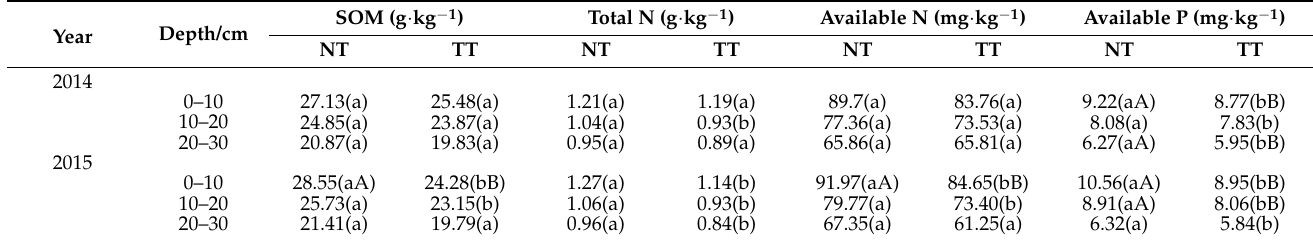
Table 2. SOM (g · kg − 1 ), total N (g · kg − 1 ), available N (mg · kg − 1 ), and available P (mg · kg − 1 ) for NT and TT trial in 0–30 cm